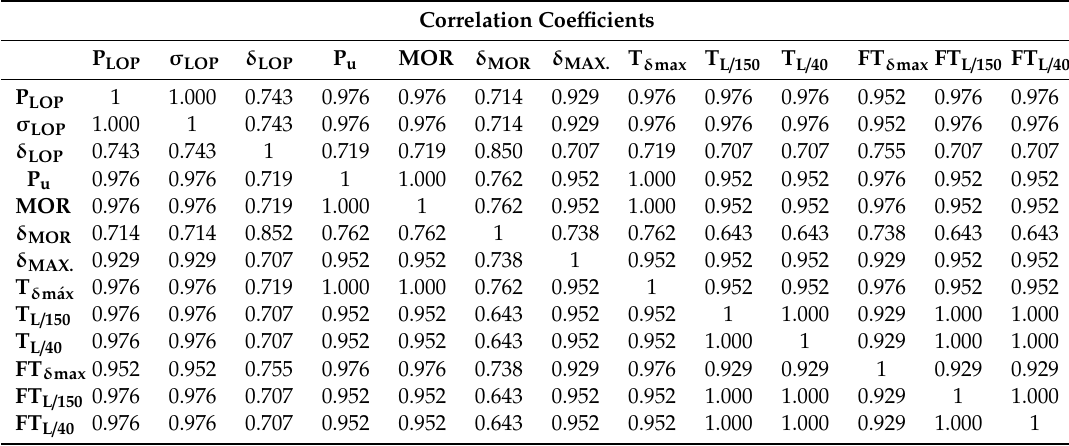
Table 4. Coe ffi cient of correlation between the mechanical parameters.